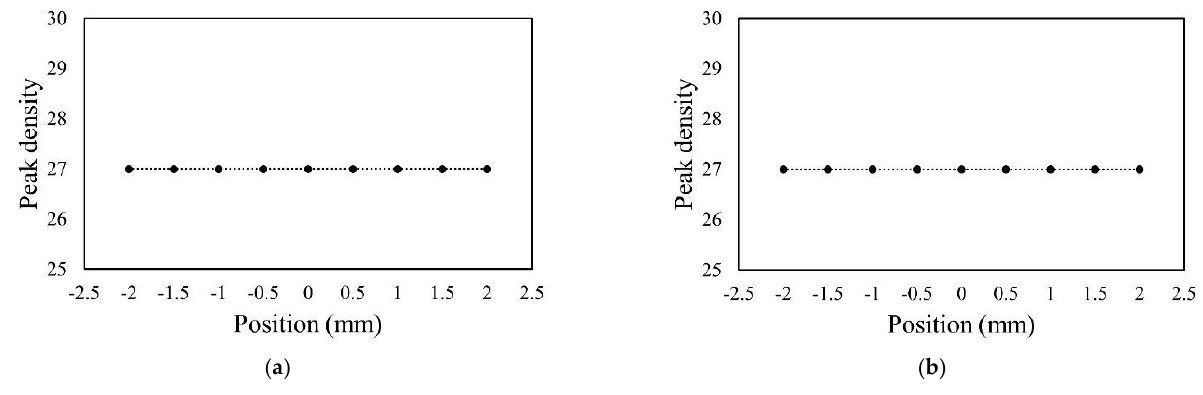
Figure 8. Peak density at all flake positions in ( a ) Sectors 2 and ( b ) 3.